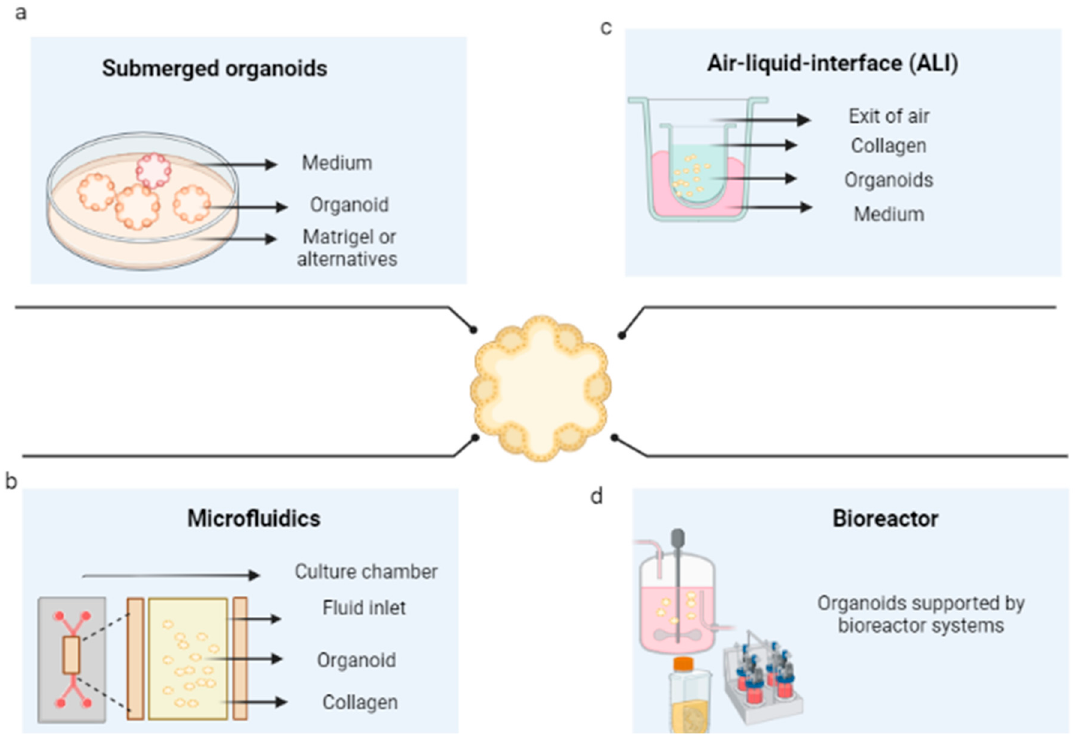
Figure 4. Organoid culture techniques. ( a ) Culture of organoids immersed in an extracellular matrix. ( b ) Organoids cultured in microfluidics. ( c ) Organoids cultured in an air–liquid interface ( d ) Organoid culture in bioreactors. Created with